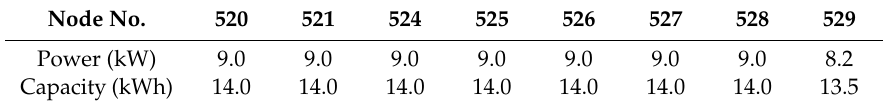
Table 4. The result of selecting the location and parameters of ESU for the analyzed LV grid (load profile B). Node No.